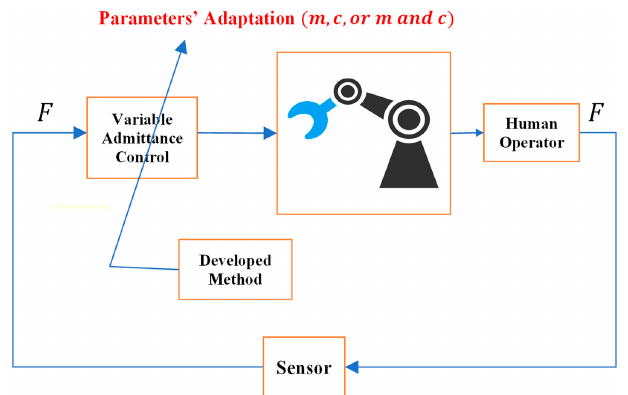
Figure 3. The VA control system for facilitating the human–robot co-manipulating task.